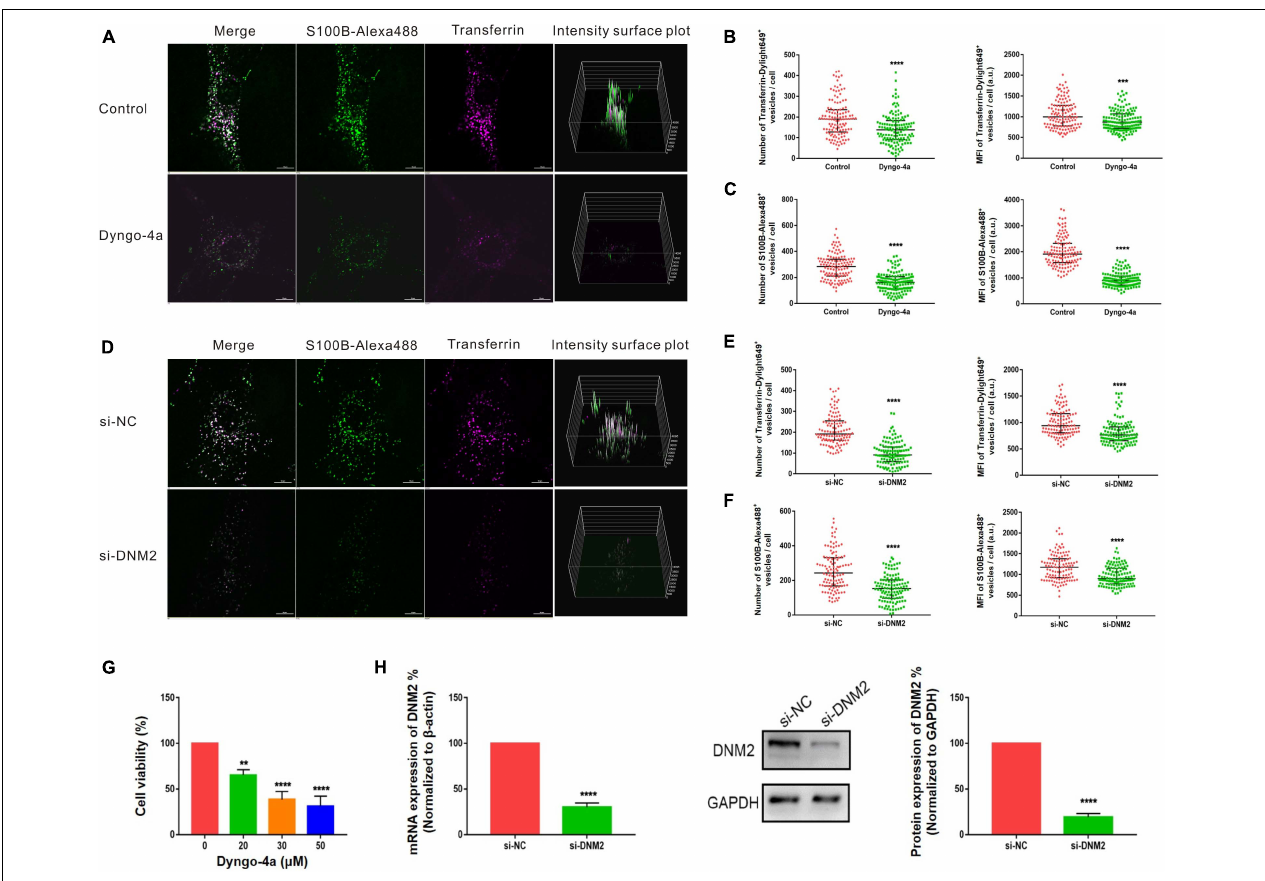
FIGURE 6 | Internalization of S100B-Alexa488 by MSCs is partially dependent on dynamin. (A–C) Effects of dyngo-4a on the uptake of S100B-Alexa488 and Transferrin-Dylight649. MSCs were pretreated with dyngo-4a or DMSO and then incubated with S100B-Alexa488 (0.1 µ M) and Transferrin-Dylight649 (15 µ g/ml) for 2 h. (A) Representative live cell confocal images. Scale bar, 10 µ m. (B,C) Quantified data showing the number and MFI of (B) Transferrin-Dylight649- and (C) S100B-Alexa488-positive vesicles. (D–F) Effects of siRNA-mediated DNM2 knockdown on the uptake of S100B-Alexa488 and Transferrin-Dylight649. MSCs were transfected with siRNA targeting DNM2 (si-DNM2) or negative control siRNA (si-NC) for 72 h and then incubated with the two fluorescent probes for 6 h as described in section “Materials and Methods”. (D) Representative live cell confocal images. Scale bar, 10 µ m. (E,F) Quantified data showing the number and MFI of (E) Transferrin-Dylight649- and (F) S100B-Alexa488-positive vesicles. Data are presented as the median and interquartile range (IQR), n (control) = 123 cells; n (Dyngo-4a) = 133 cells; n (si-NC) = 112 cells; n (si-DNM2) = 116 cells. All the experiments were repeated for three times. (G) Cell viability detected with CCK8 assays after being treated with the indicated concentrations of dyngo-4a for 2.5 h. (H) Relative mRNA and protein levels of DNM2 in cells transfected with si-DNM2 or si-NC. Data are the means of three independent biological replicates (mean ± SEM). Statistical analysis was done using t -tests; ** P < 0.01, *** P < 0.001, **** P < 0.0001, ns, not significant versus the control